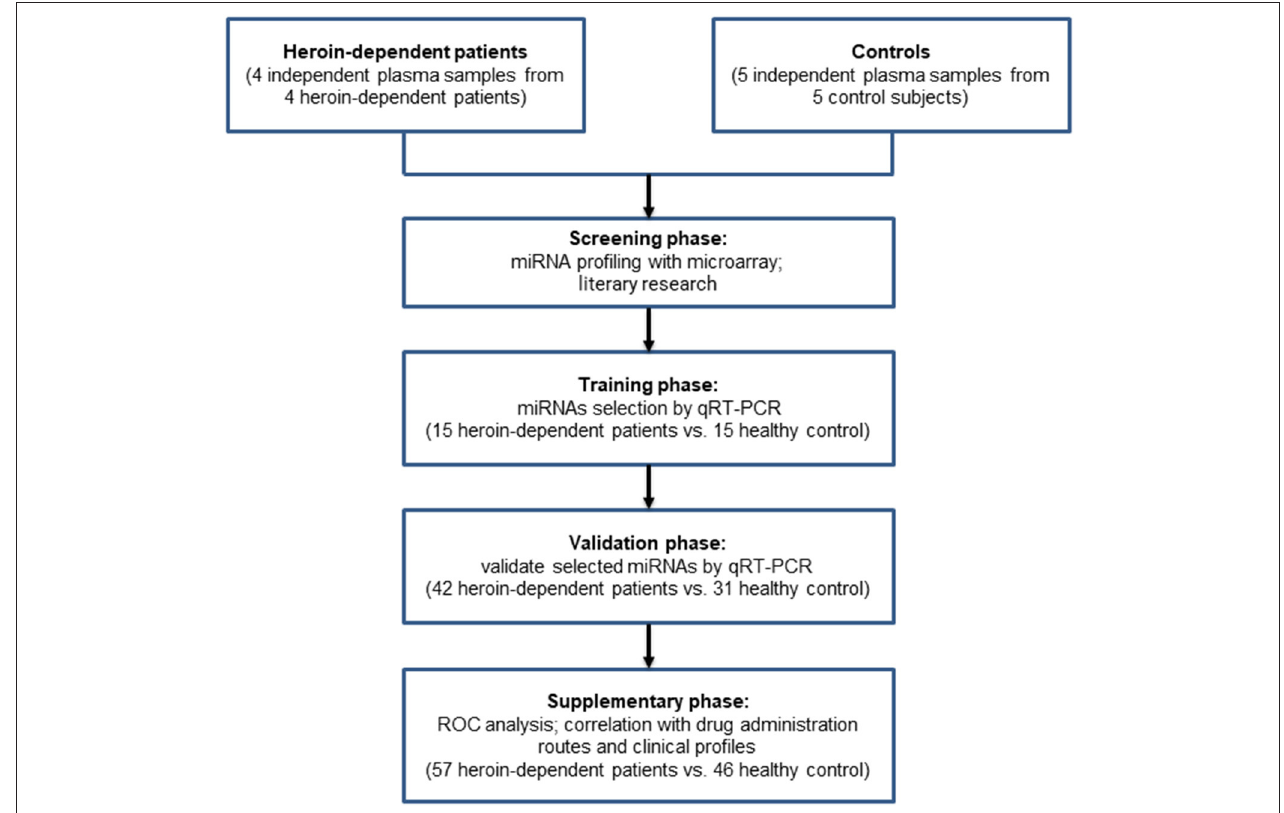
FIGURE 1 | Flowchart of the study